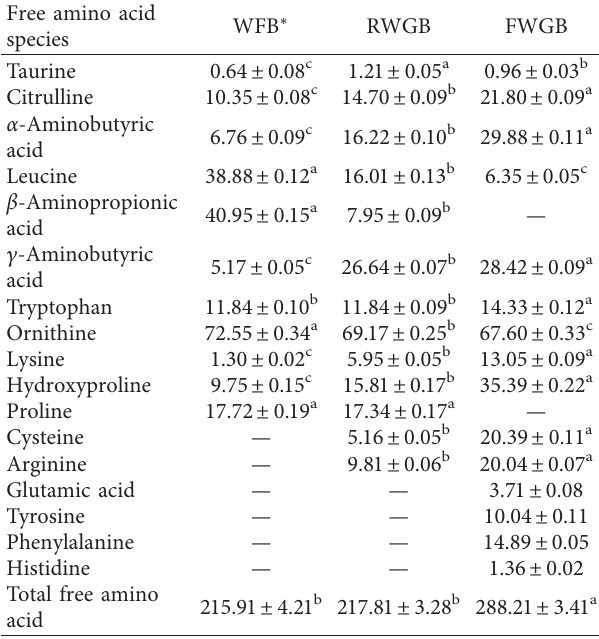
Figure 1. Bread specific volume is the ultimate parameter